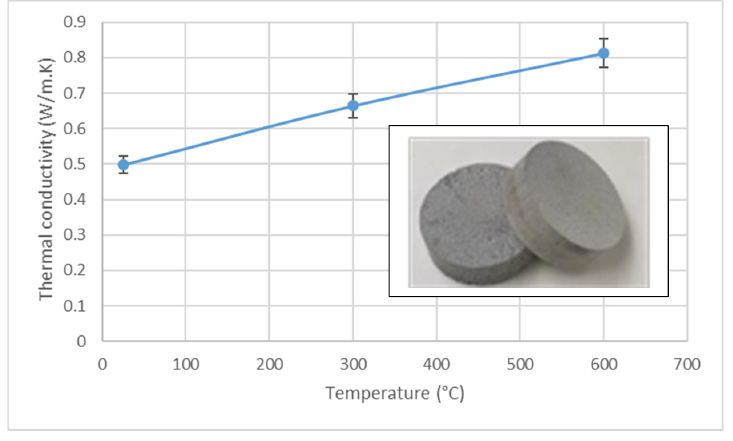
Figure 4. Thermal conductivity of the protective material at 20, 300, and 600 °C.